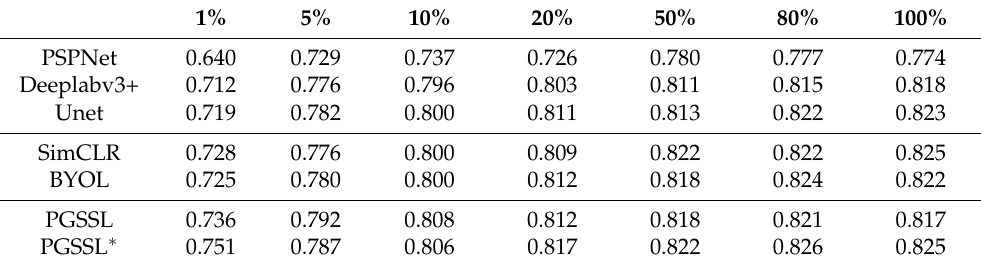
Table 5. Experimental effects of various methods on EA dataset with different